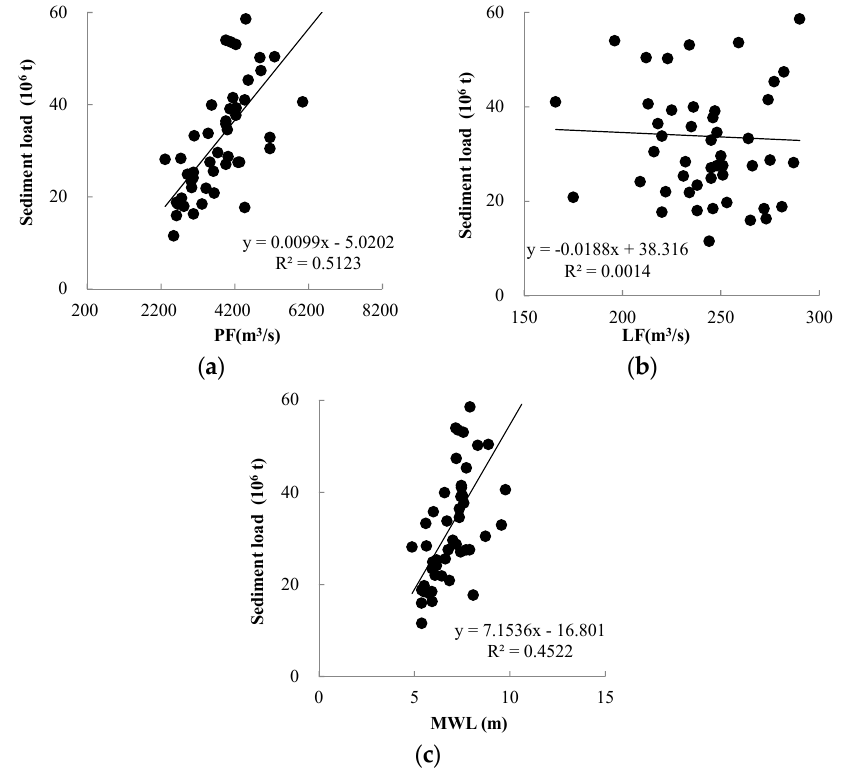
Figure 6. Scatter plots between PF, LF, MWL, and annual sediment load during the periods of 1957–2006 at Jiuzhou Station. Table 3. Correlation coefficients between observed hydrological elements and sediment load at Jiuzhou Station from 1957 to 2006.